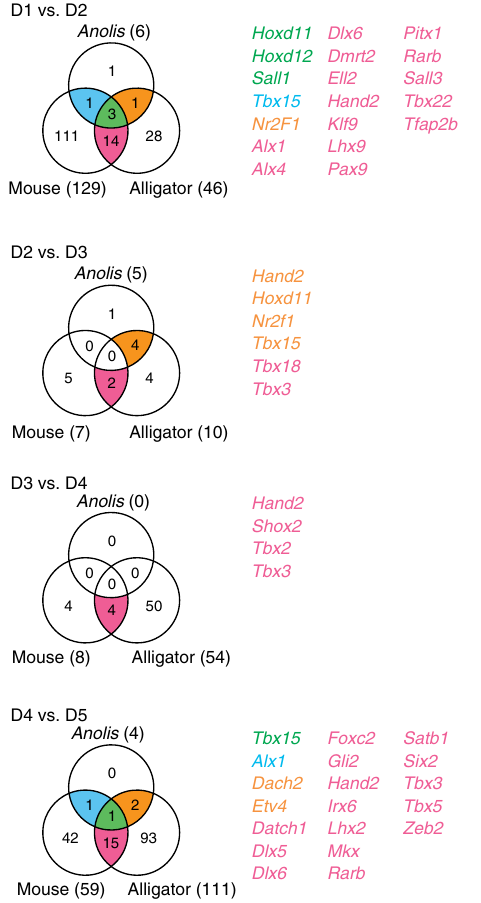
patterns of expression change at this position: in all limbs sampled Hand2, Hoxd11, Hoxd12, and Tfap2b are more highly expressed in D2 than D1, and Alx1 and Pax9 are more lowly expressed in D2 than D1 (Fig. 4b).